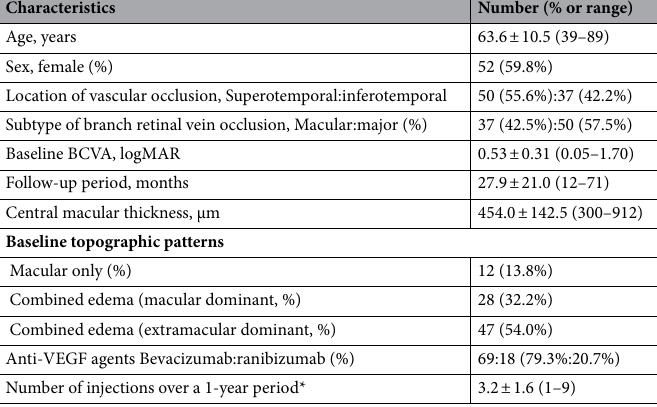
Table 1. Baseline characteristics and treatment details of the included patients with macular edema secondary to branch retinal vein occlusion (n = 87). Continuous values are denoted as mean ± standard deviation. BCVA best-corrected visual acuity, VEGF vascular endothelial growth factor, logMAR logarithm of the minimum angle of resolution. *Including the first injection at baseline.